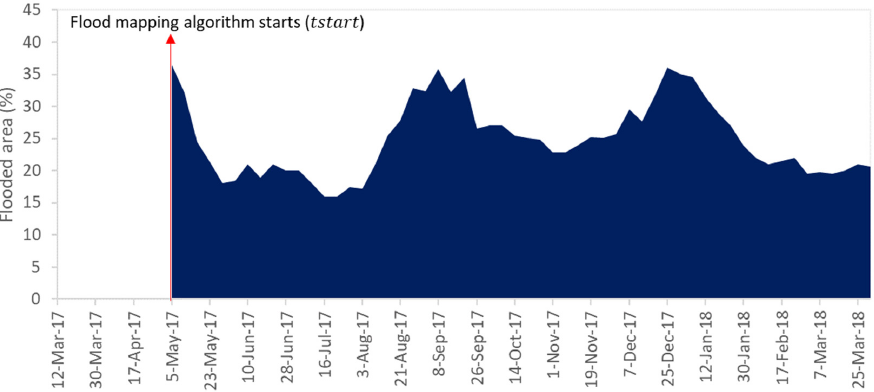
Figure 16. Percentage of the flooded area in An Giang province in 2017–2018.